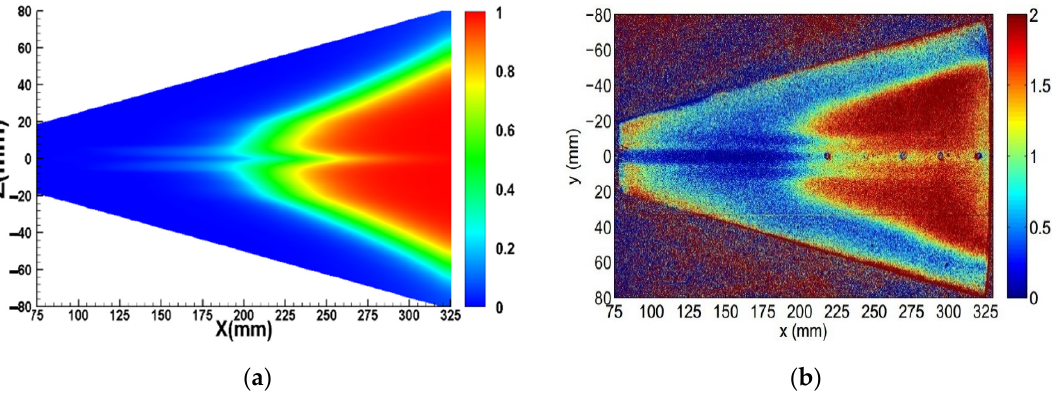
Figure 1. Comparison of γ and TSP distributions. ( a ) γ distribution, numerical simulation, ( b ) TSP image, wind tunnel experiment result.